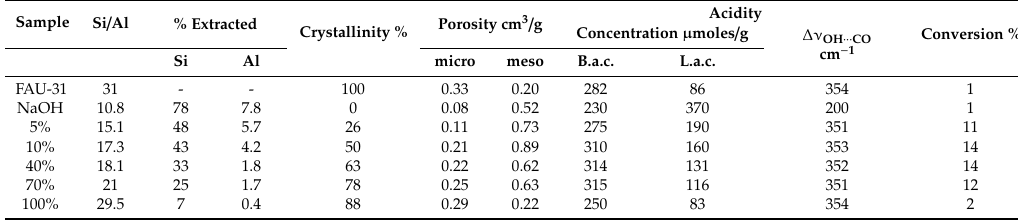
Table 2. The Si / Al values, the amounts of Si and Al extracted, crystallinity, N 2 porosity, concentration of Brønsted and Lewis acid sites, the acid strength of Si-OH-Al groups ( ∆ ν OH ··· CO ). Conversion in α -pinene isomerization after 5 min of reaction at 363 K. The data concerning parent zeolite Y (FAU-31) and zeolites desilicated with NaOH / TBAOH mixtures of various TBAOH contents (0, 5, 10, 40, 70 and 100 mol % of TBAOH) are presented. The desilication was done at 293 K. The data were adapted (with the permission) from